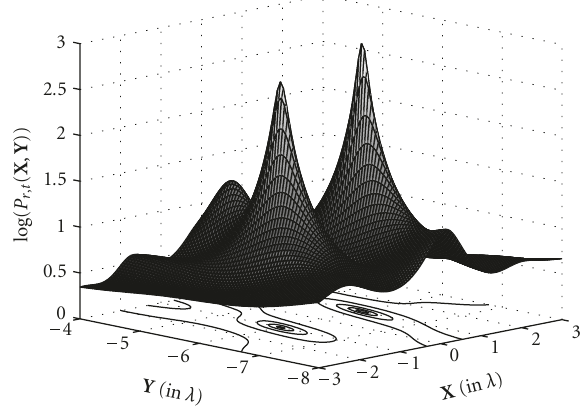
Figure 3: High-dimensional signal subspace method pseudospec- trum for the multiple scattering case for SNR = 20 dB.